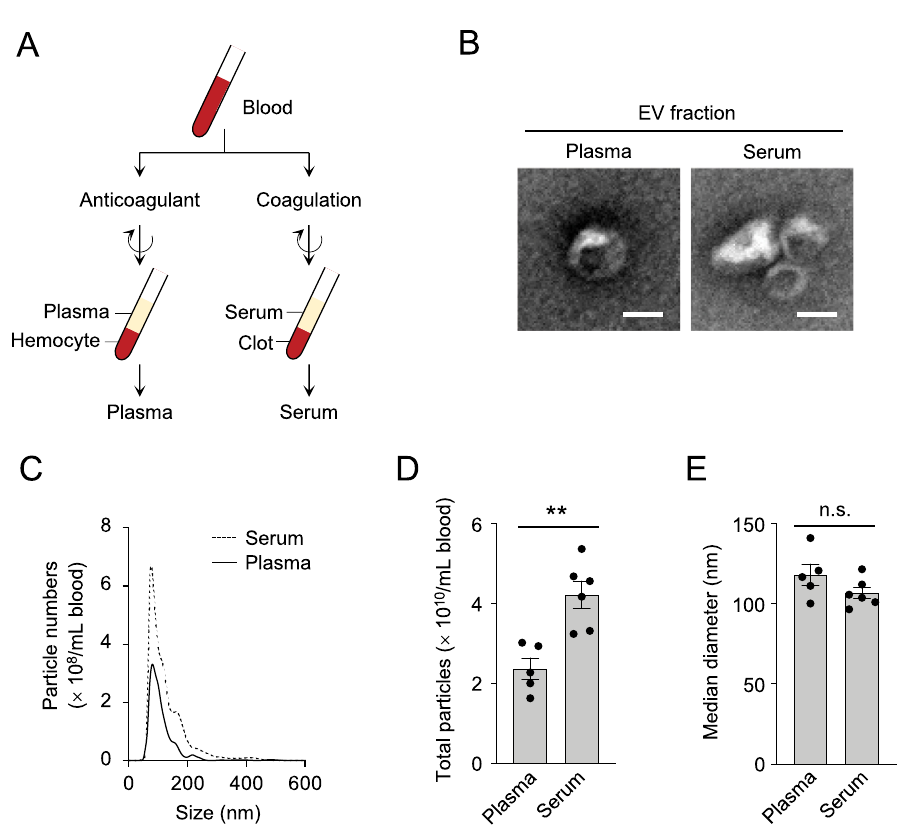
Fig 1. Serum sEV fractions contain more EV particles than plasma sEV fractions in mouse blood. (A) Schematic representation of the preparation methods of plasma and serum. Plasma was separated from anticoagulant-treated blood by removing hemocytes and other precipitates by centrifugation. Serum was separated from coagulated blood by removing blood clots by centrifugation. (B) Transmission electron micrographs of particles in the sEV fractions derived from plasma and serum. Scale bars, 100 nm. (C-E) NTA of the sEV fractions derived from plasma and serum. A plot showing the size distribution of the EV particles (C) and bar graphs showing the numbers (D) and median diameters (E) of the particles in the sEV fractions isolated from plasma and serum. Data are shown as the average ± SEM (plasma, n = 5; serum, n = 6). �� P < 0.01, Student t -test. n.s., not significant. Experiments were performed independently at least three times, and representative data are shown. In C and D, particle numbers are normalized to original blood volumes.